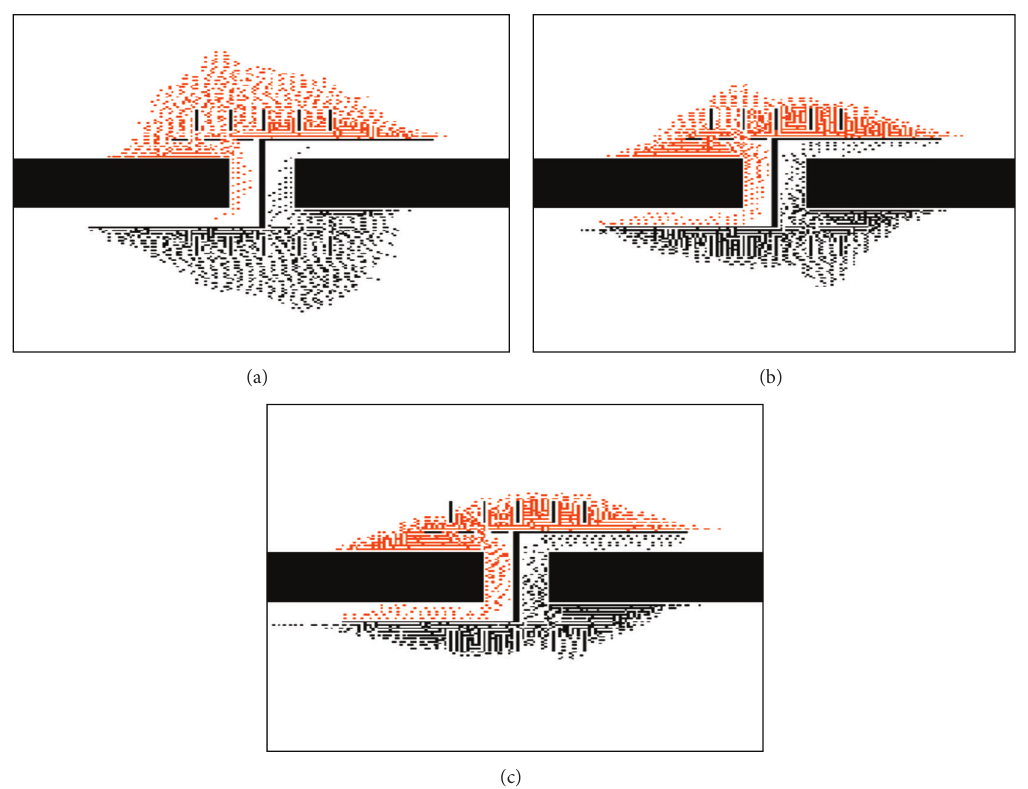
Figure 9: Simulations of evacuation for a bidirectional underpass after setting isolated